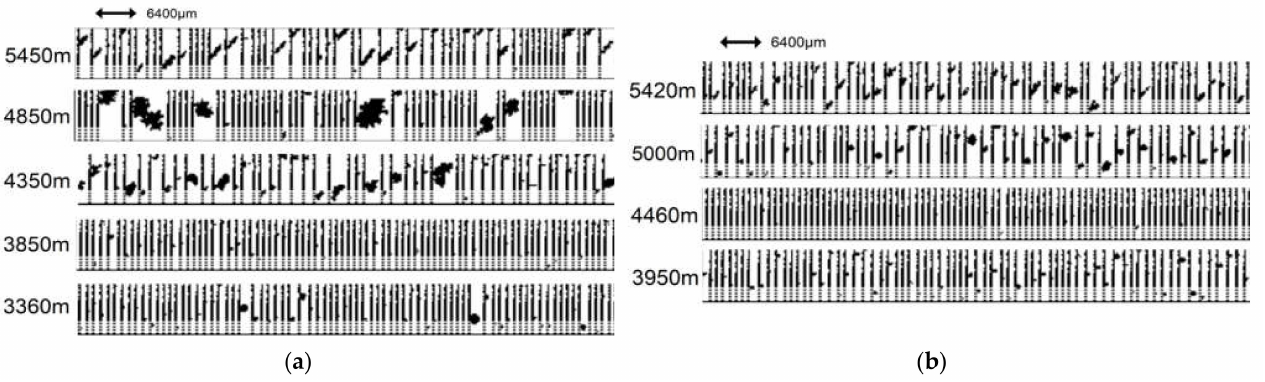
Figure 10. 2D-P images at selected heights during ( a ) the first Baicheng Y-12 aircraft flight and ( b ) the second Baicheng Y-12 aircraft